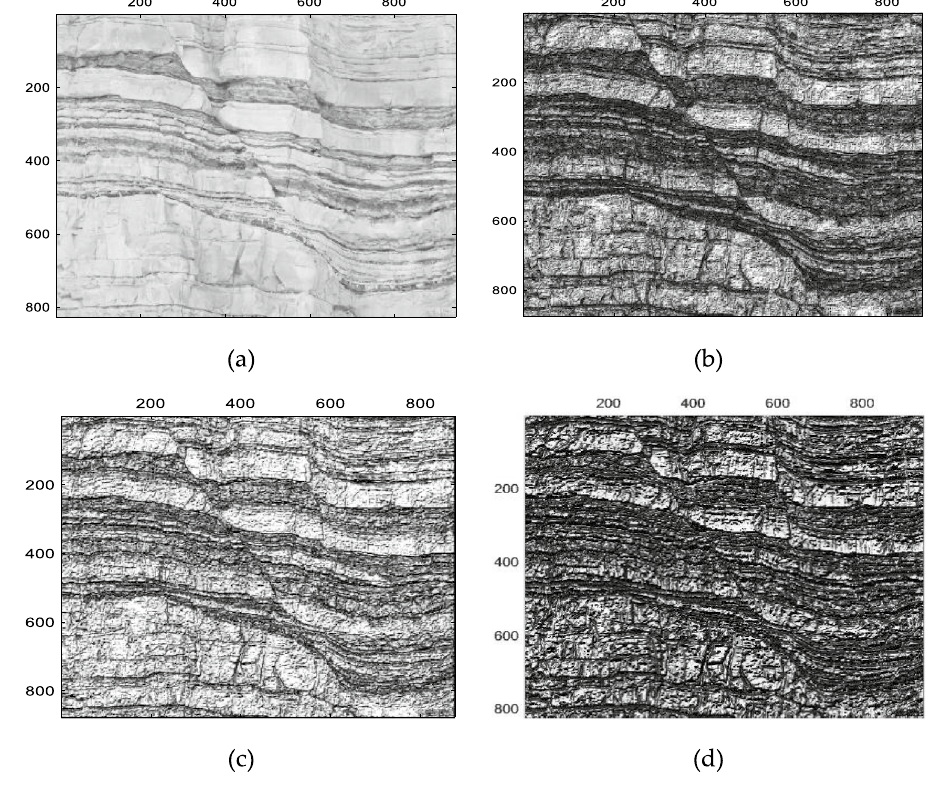
Fig. 7 Results of the actual geological section test: a original picture and results obtained by the b LBP/VAR method; c median filtering- LBP/VAR method; and d guided filtering- LBP/VAR